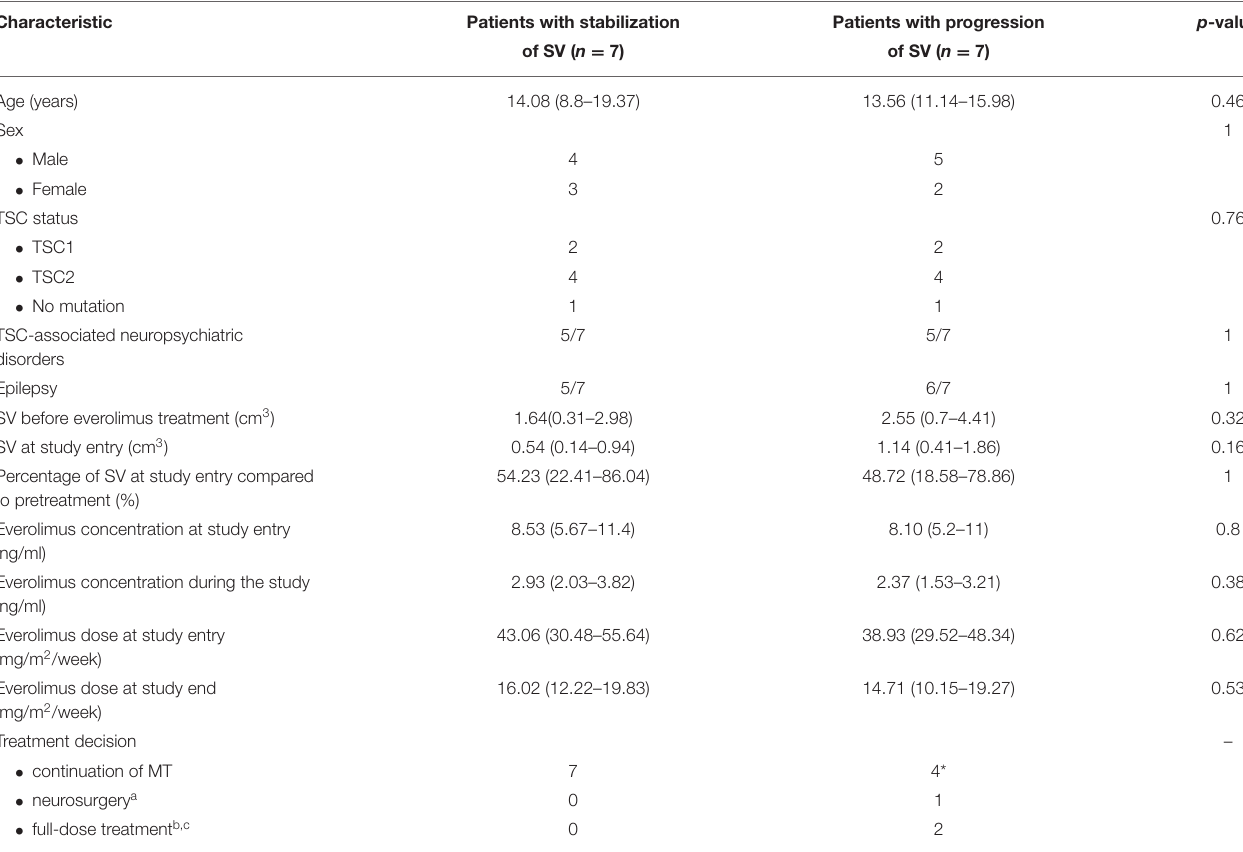
TABLE 2 | Comparison of patients with stable SEGA volume (SV) vs. patients with progression of SEGA volume at any time during the study (two-tailed Fischer’s exact test, UMW test according to distribution of the data). Characteristic Patients with